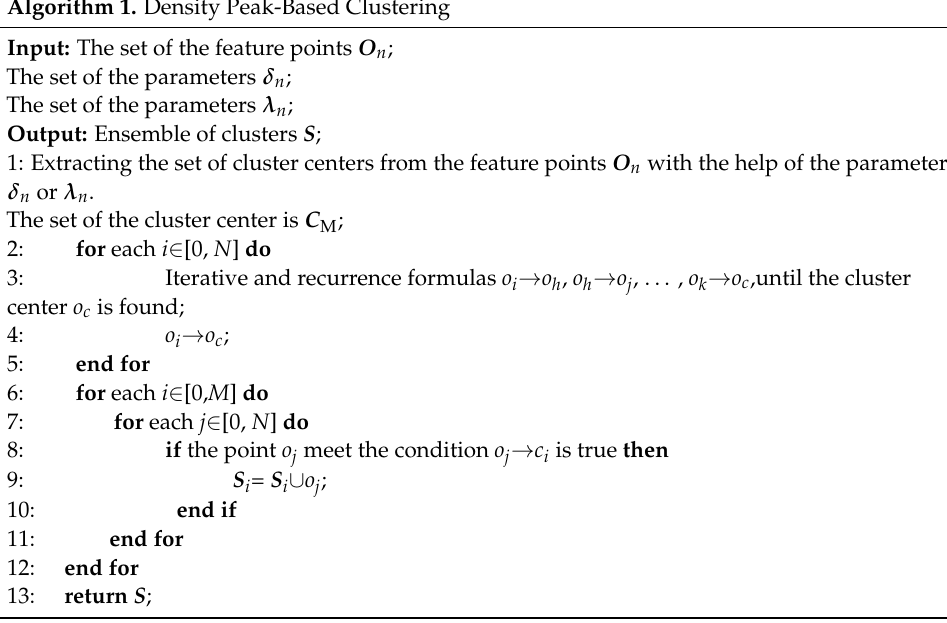
Algorithm 1. Density Peak-Based